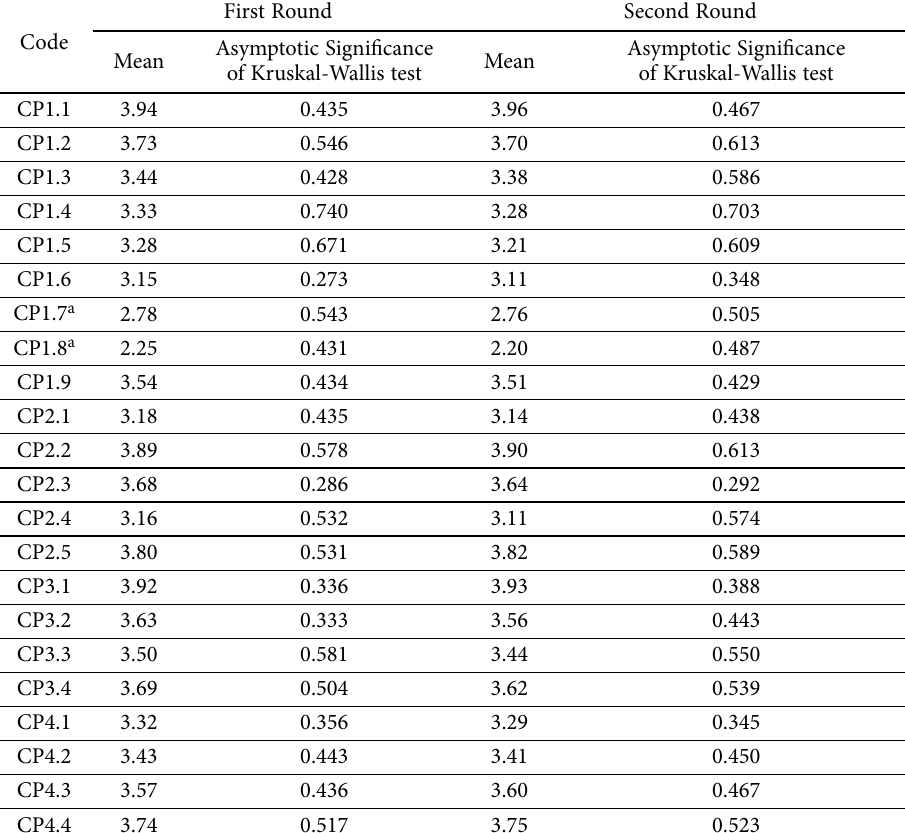
Table 3. Results of the two-round Delphi interview Code